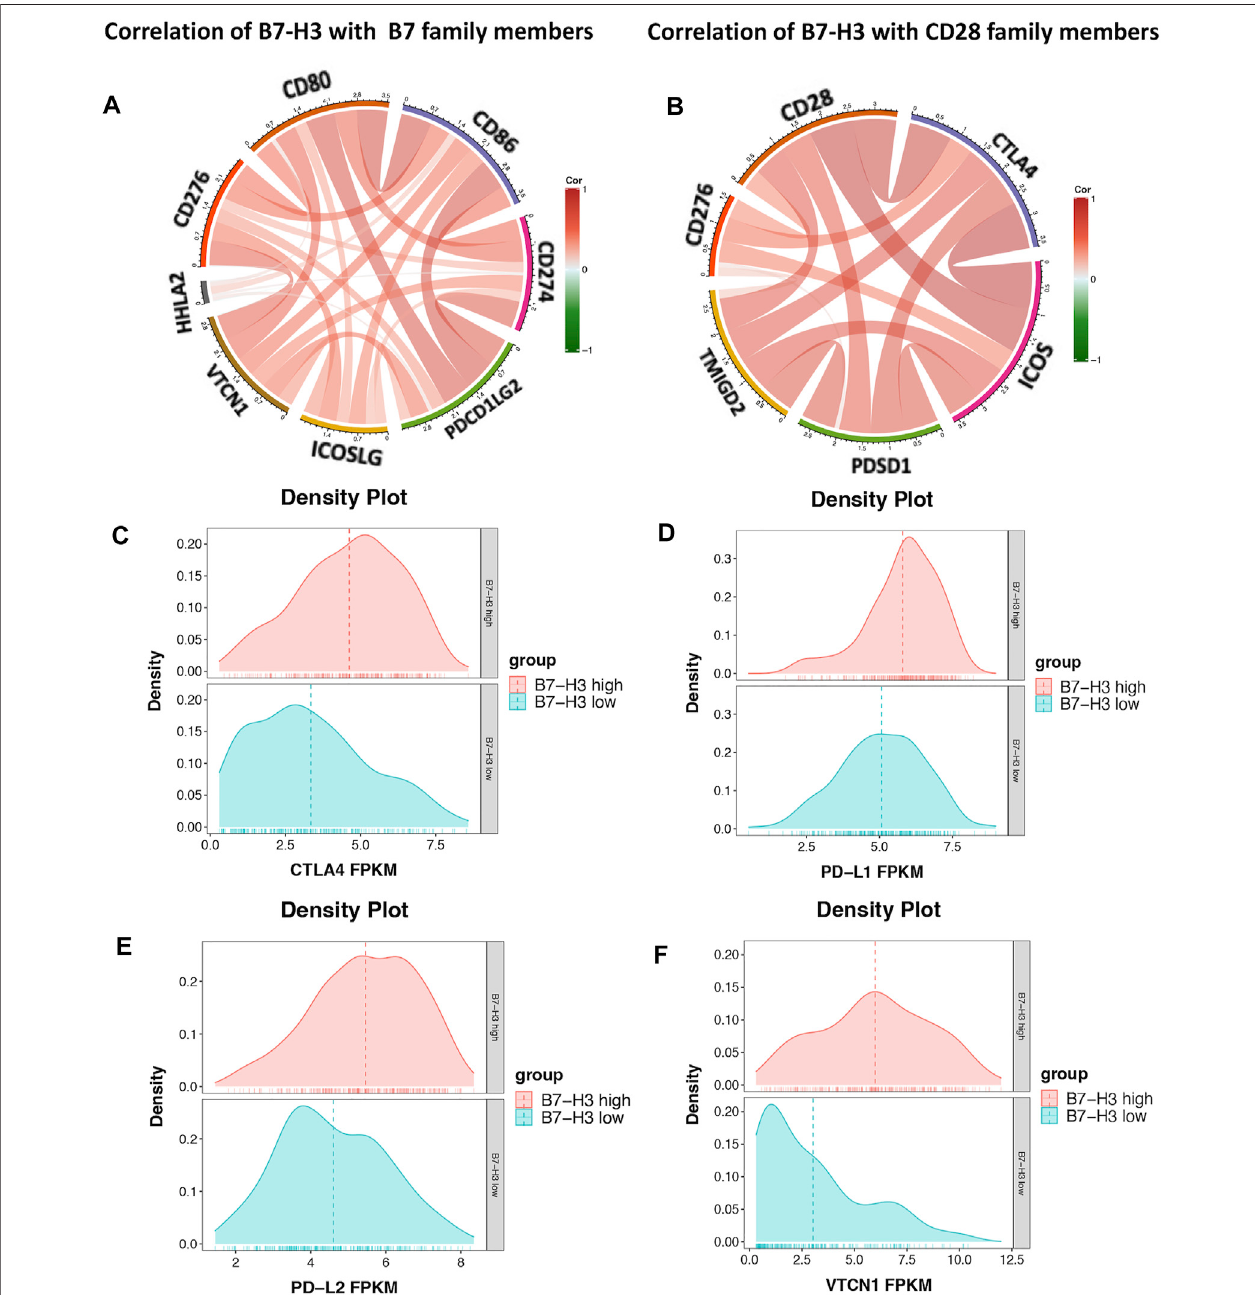
FIGURE 5 | Correlation of B7-H3 and B7 family members (A) . Correlation of B7-H3 and CD28 family members (B) . Distribution of PD-L1, PD-L2, CTLA4, and VTCN1 in high- and low-expression groups of B7-H3 (C – F) .